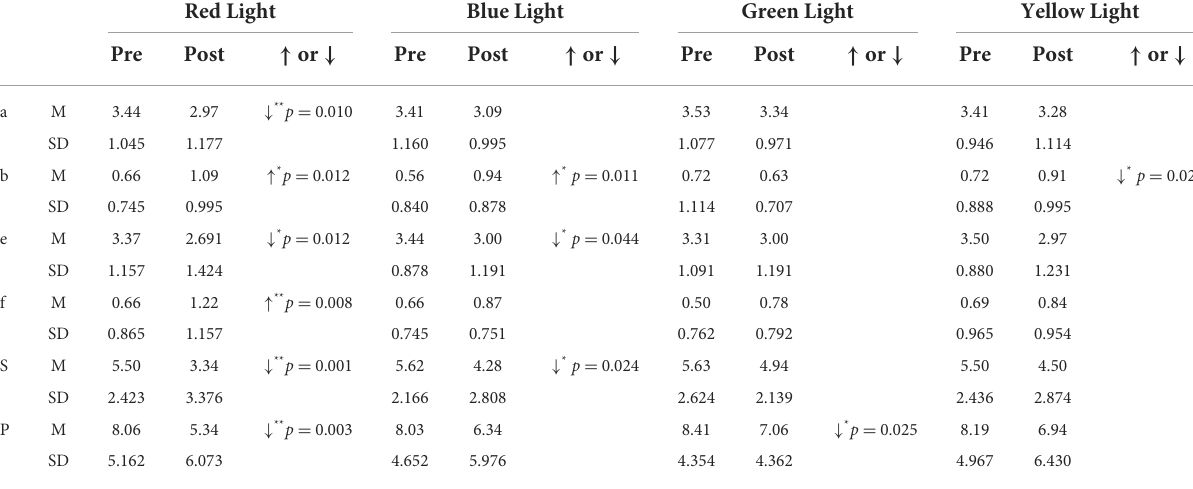
TABLE 6 Changes in Two-Dimensional Mood Scale scores pre- and post-intervention. Red Light Blue Light Green Light Yellow Light Pre